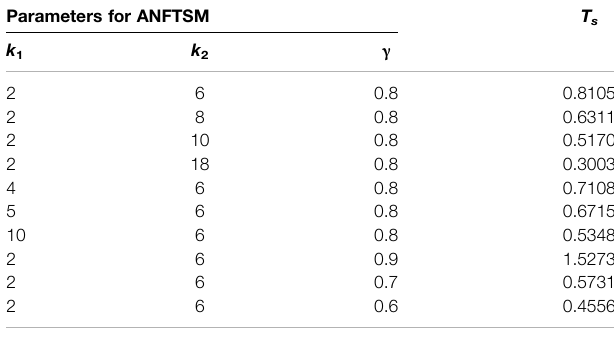
TABLE 1 | Upper bounds of settling-time for ANFTSM controller with various parameter values for Example 1. Parameters for ANFTSM